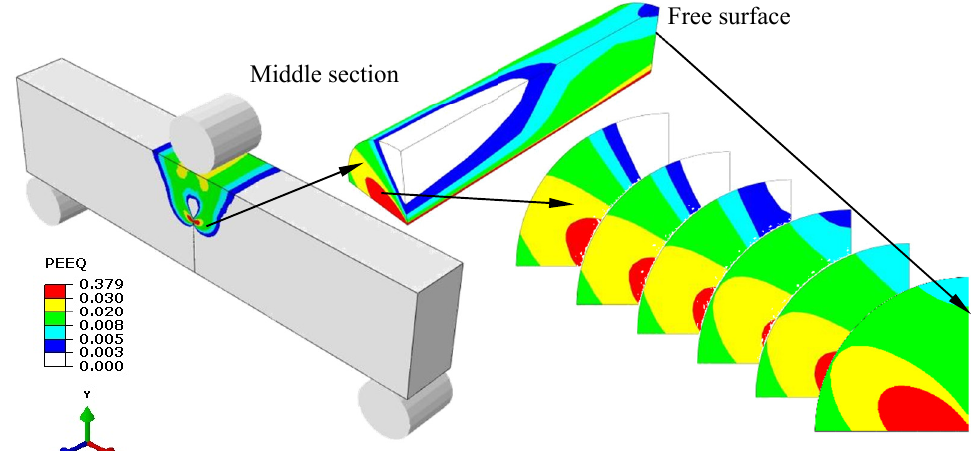
Figure 3. Equivalent plastic strain around crack fronts in sections.